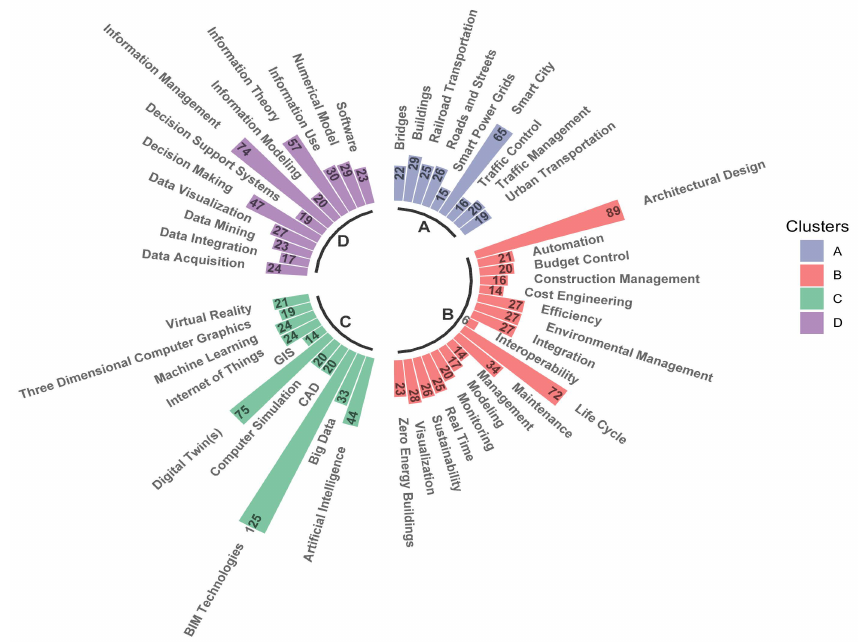
Figure 7. The research agenda for future research in the field of digitization of